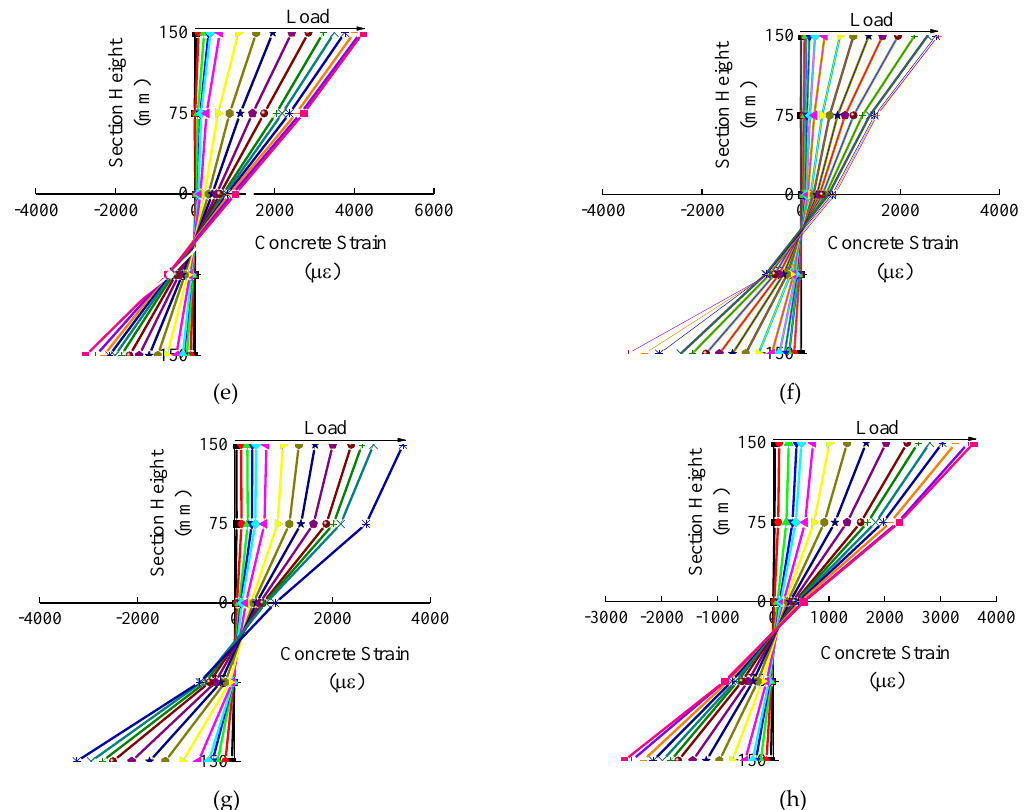
Figure 7. The strain curves of the normal section of the columns: ( a ) C30 - 1.2A; ( b ) C30 - 1.2B; ( c ) C40 - 1.2A; ( d ) C40 - 1.2B; ( e ) C50 - 1.2A; ( f ) C50 - 1.2B; ( g ) C40 - 1.6; ( h ) C40 - 2.0.